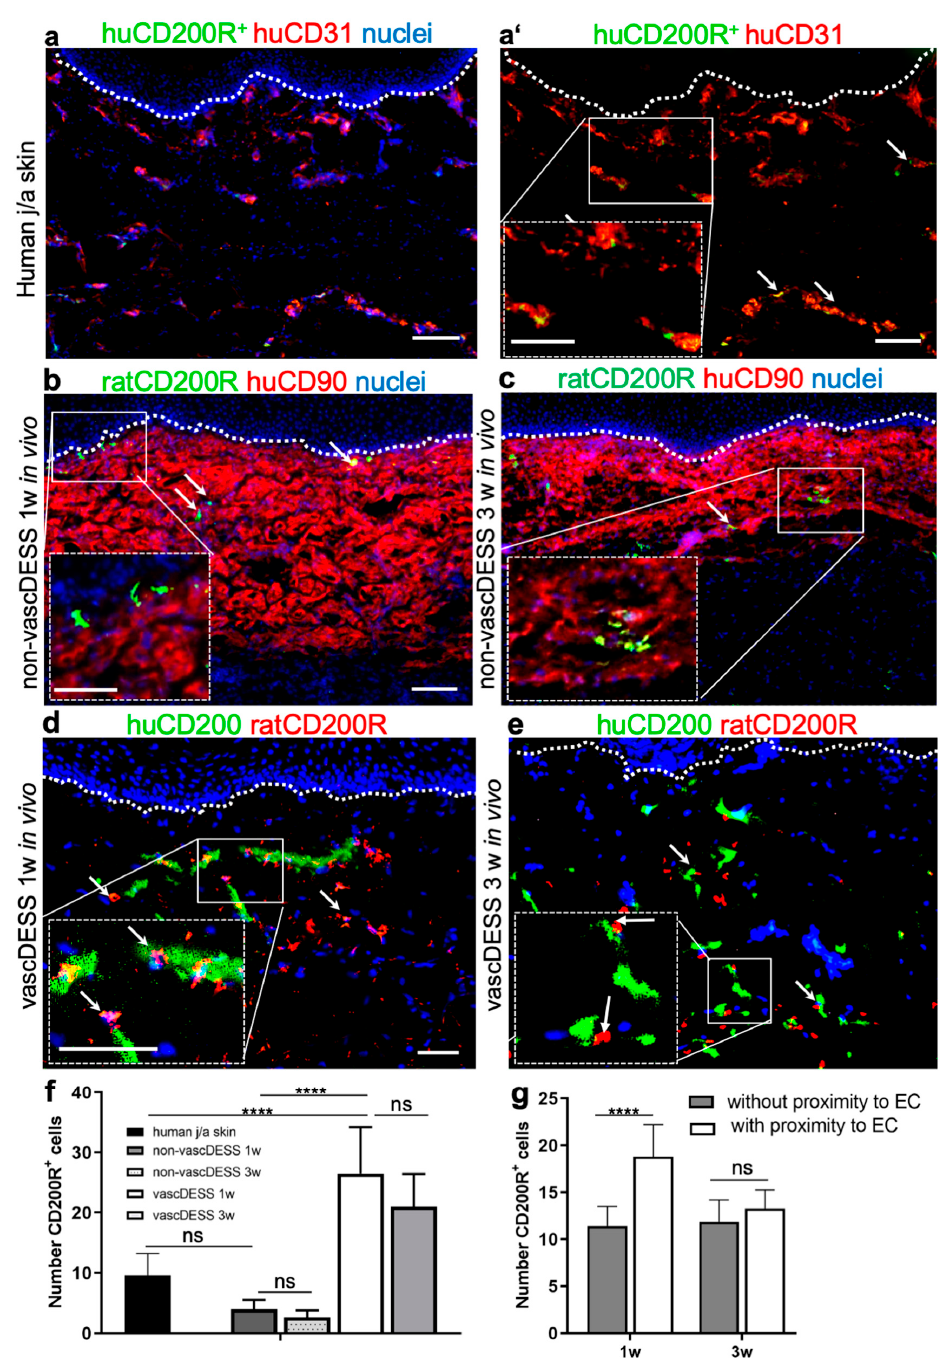
Figure 8. Expression of CD200R in human j/a skin as well as in non-vascDESS and vascDESS. ( a , a’ ) Immunofluorescence pictures of j/a skin stained against CD31 (red) and CD200R (green). Note that CD200R + immune cells (9.65 ± 3.56) are closely associated with CD31 + capillaries. ( b , c ) The expression of CD200R in non-vascDESS at one week (4 ± 1.55, p = 0.1551 vs. normal skin) ( b ) and 3 weeks (2.67 ± 1.55, p = 0.0565 vs. normal skin) ( c ) after transplantation. Once again, CD200R- expressing cells were located in close proximity to the CD31 + capillaries. ( d , e ) The expression of CD200R in vascDESS one week (26.5 ± 7.71, p < 0.0001 vs. non-vascDESS 1w, **** p < 0.0001 vs. human skin) ( d ) and three weeks (21.31 ± 5.4, p < 0.0001 vs. non-vascDESS 1w, p < 0.0001 vs. human skin) ( e ) post-transplantation. Numerous CD200R + cells were visible throughout the entire dermal layer and adhered mainly to the CD200 + endothelium. ( f ) Quantification of CD200R-expressing cells in the dermal compartments of j/a human skin as well as in non-vasc and vascDESS after one